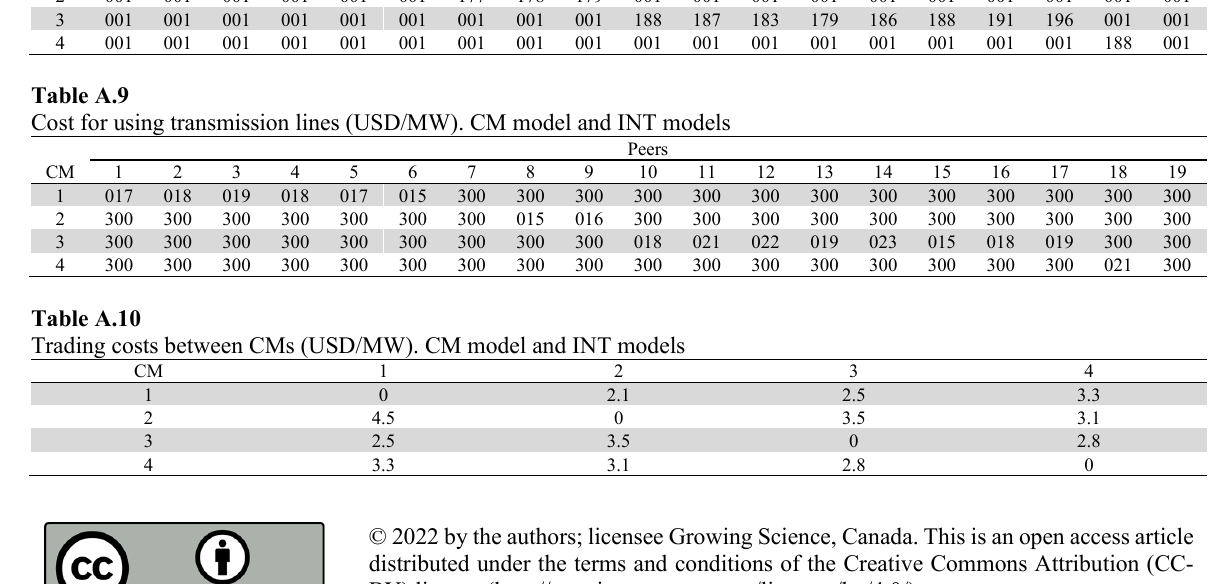
Selling prices between CMs and peers (USD/MWh). CM and INT models CM 1